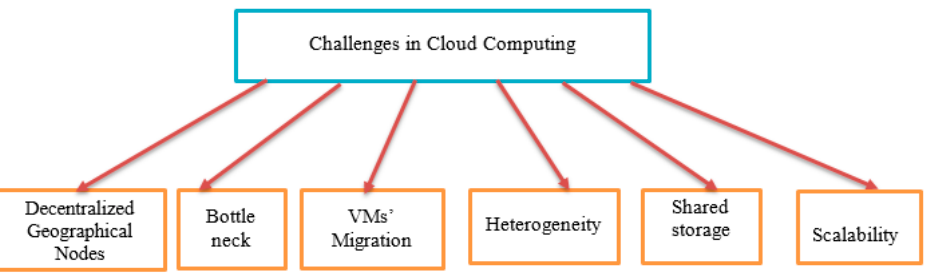
Figure 2. Challenges in cloud computing.